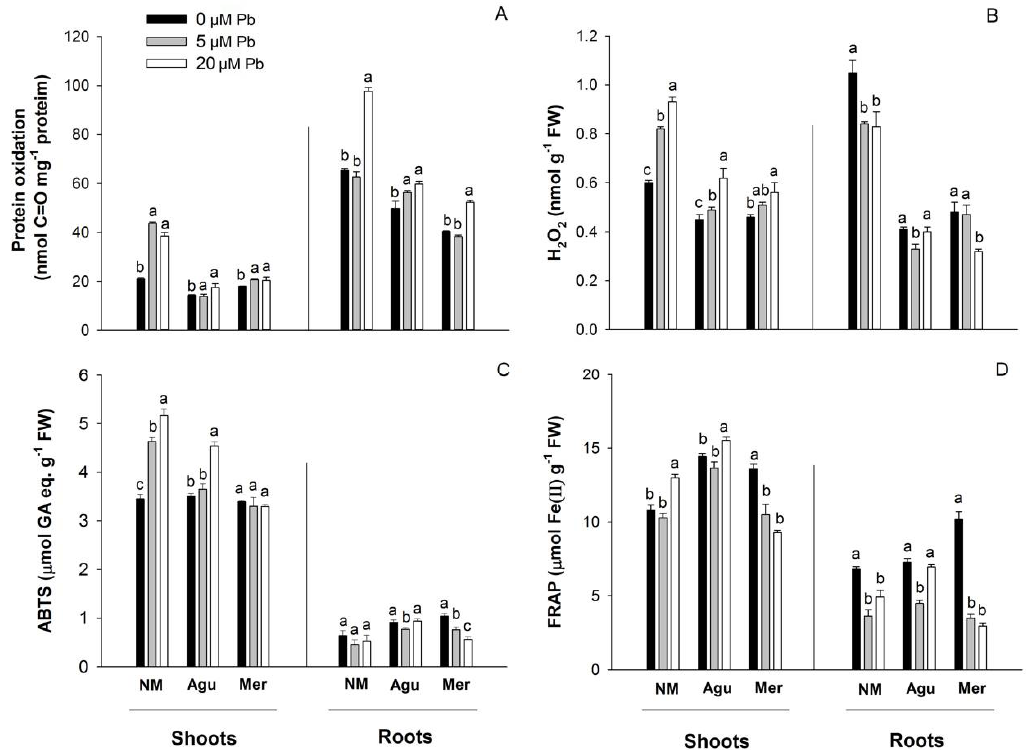
Figure 5. Carbonyl group contents ( A ), H 2 O 2 concentration ( B ), ABTS radical scavenging capacity ( C ) and ferric-reducing antioxidant power ( D ) in shoots and roots of non-mining (NM) and mining Agustin (Agu) and Mercader (Mer) Z. fabago seedlings exposed to 0, 5 and 20 µM Pb(NO 3 ) 2 for 4 weeks. Values are given as mean ± SE. Different letters correspond to significant differences between doses within the same population and organ ( p < 0.05).